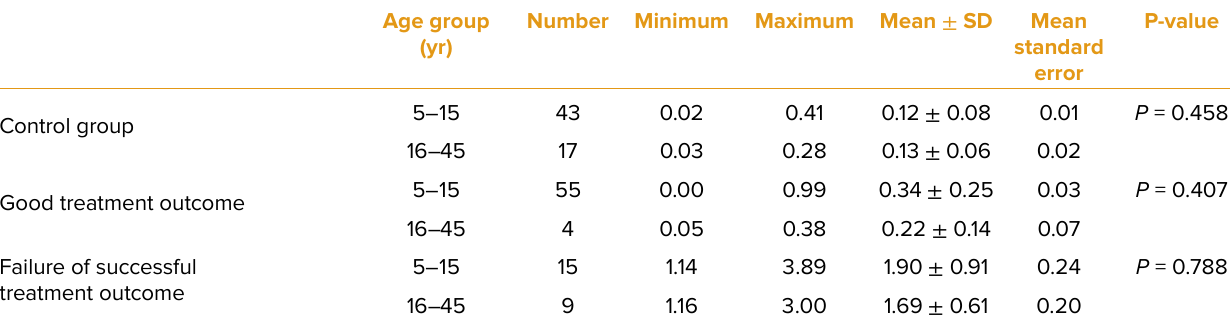
Table 3. Comparison of the mean of the interocular axial length difference (mm) between the children and adult group based on amblyopia treatment outcomes.